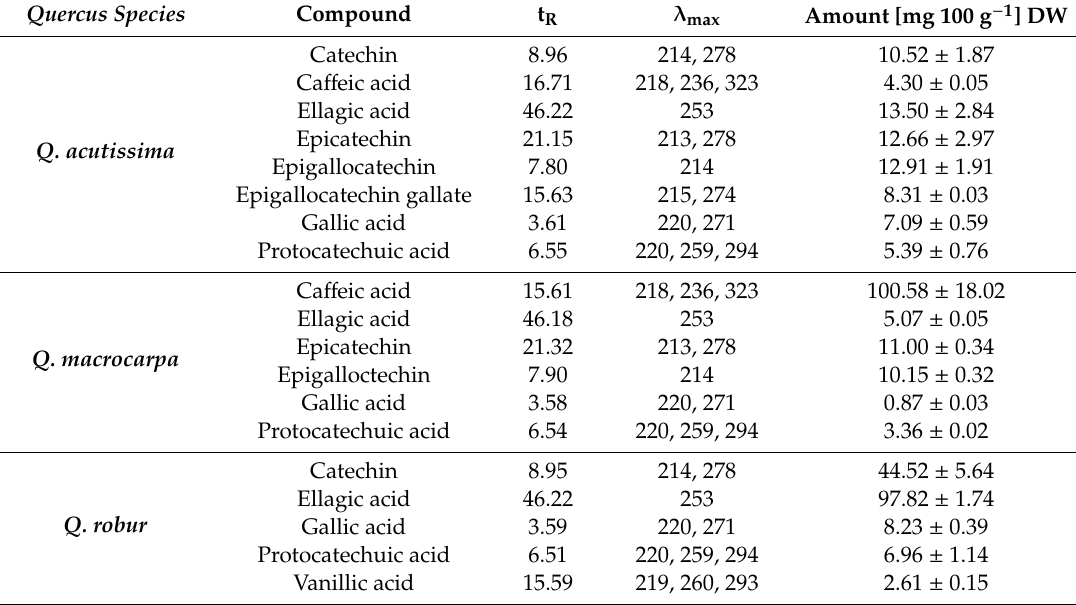
Table 1. The phenolic acids and catechin derivatives compositions of Q. acutissima , Q. macrocarpa and Q. robur outer bark